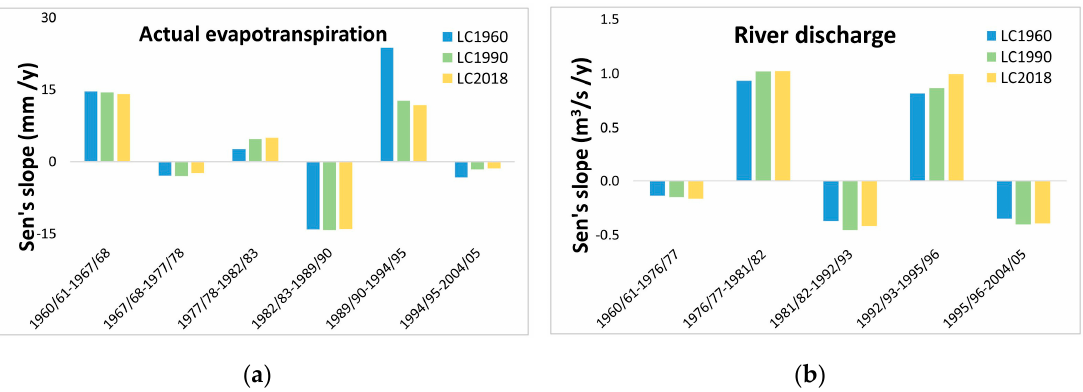
Figure 14. Sen’s slope for actual evapotranspiration ( a ) and river discharge ( b ) for LC1960, LC1990, and LC2018.